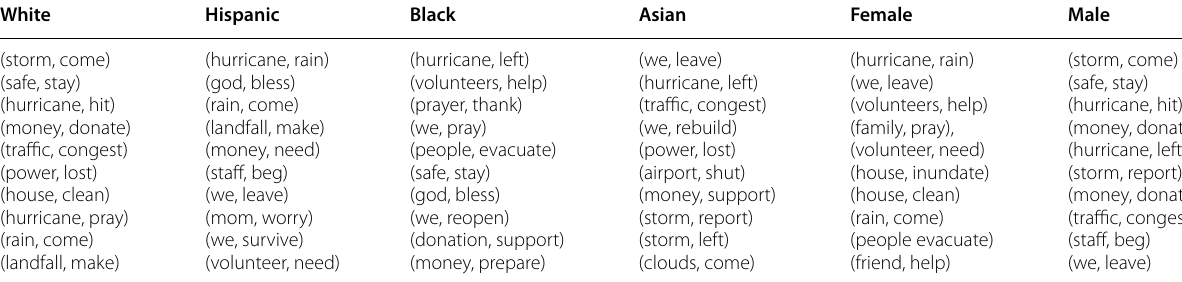
Fig. 6 Perception-level and humanitarian-level situational awareness by gender and race/ethnicity